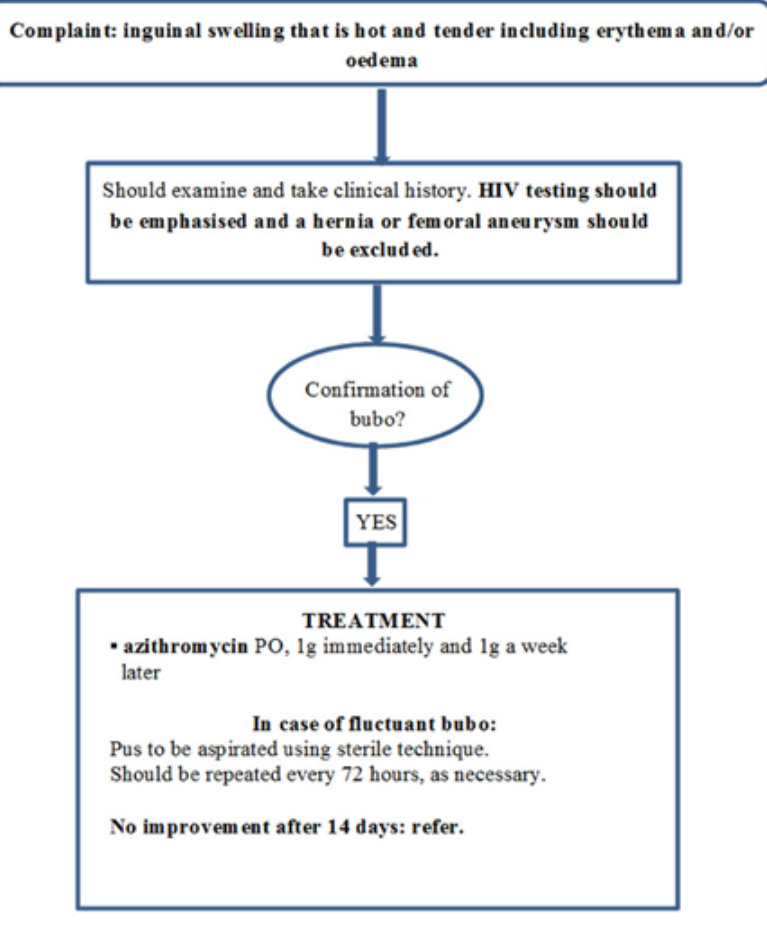
Figure 6: Flowchart of syndromic treatment of a swollen and inflamed lymph node (bubo). (adapted from the revised bubo flowchart of the Primary Health Care Standard Treatment Guidelines and Essential Drugs List, 2015)